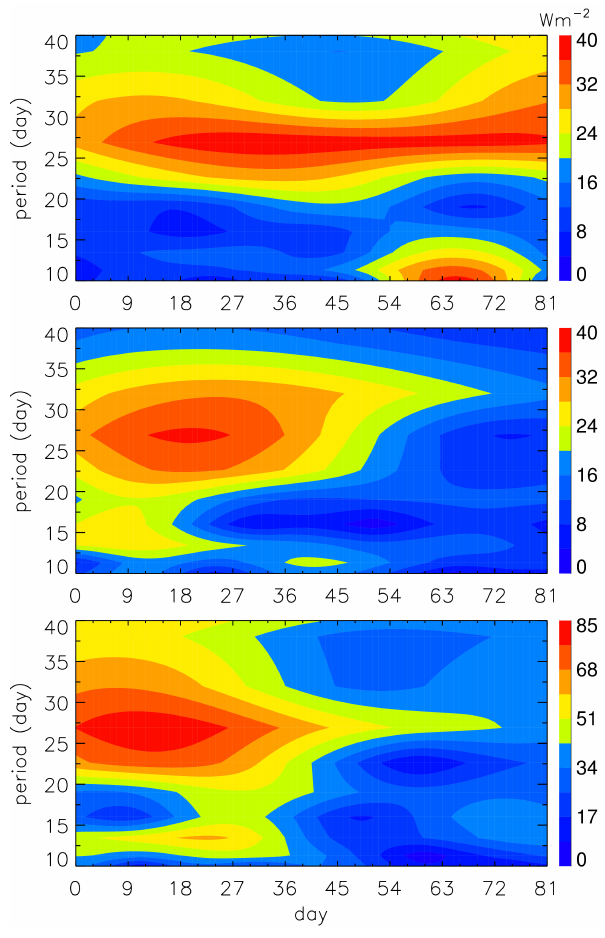
Figure 13. Wavelet spectrum of OLR at (top) 30 ◦ E, (middle) 70 ◦ E and (bottom) 150 ◦ E (averaged over 5–20 ◦ N) from NCEP/NCAR- interpolated OLR data.